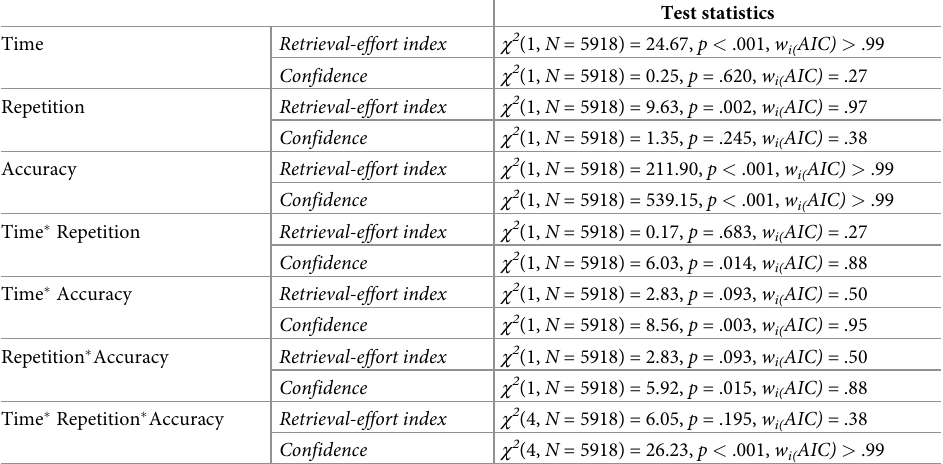
Table 3. Results of model comparisons assessing the effects of time, repetition and accuracy on the retrieval-effort index and